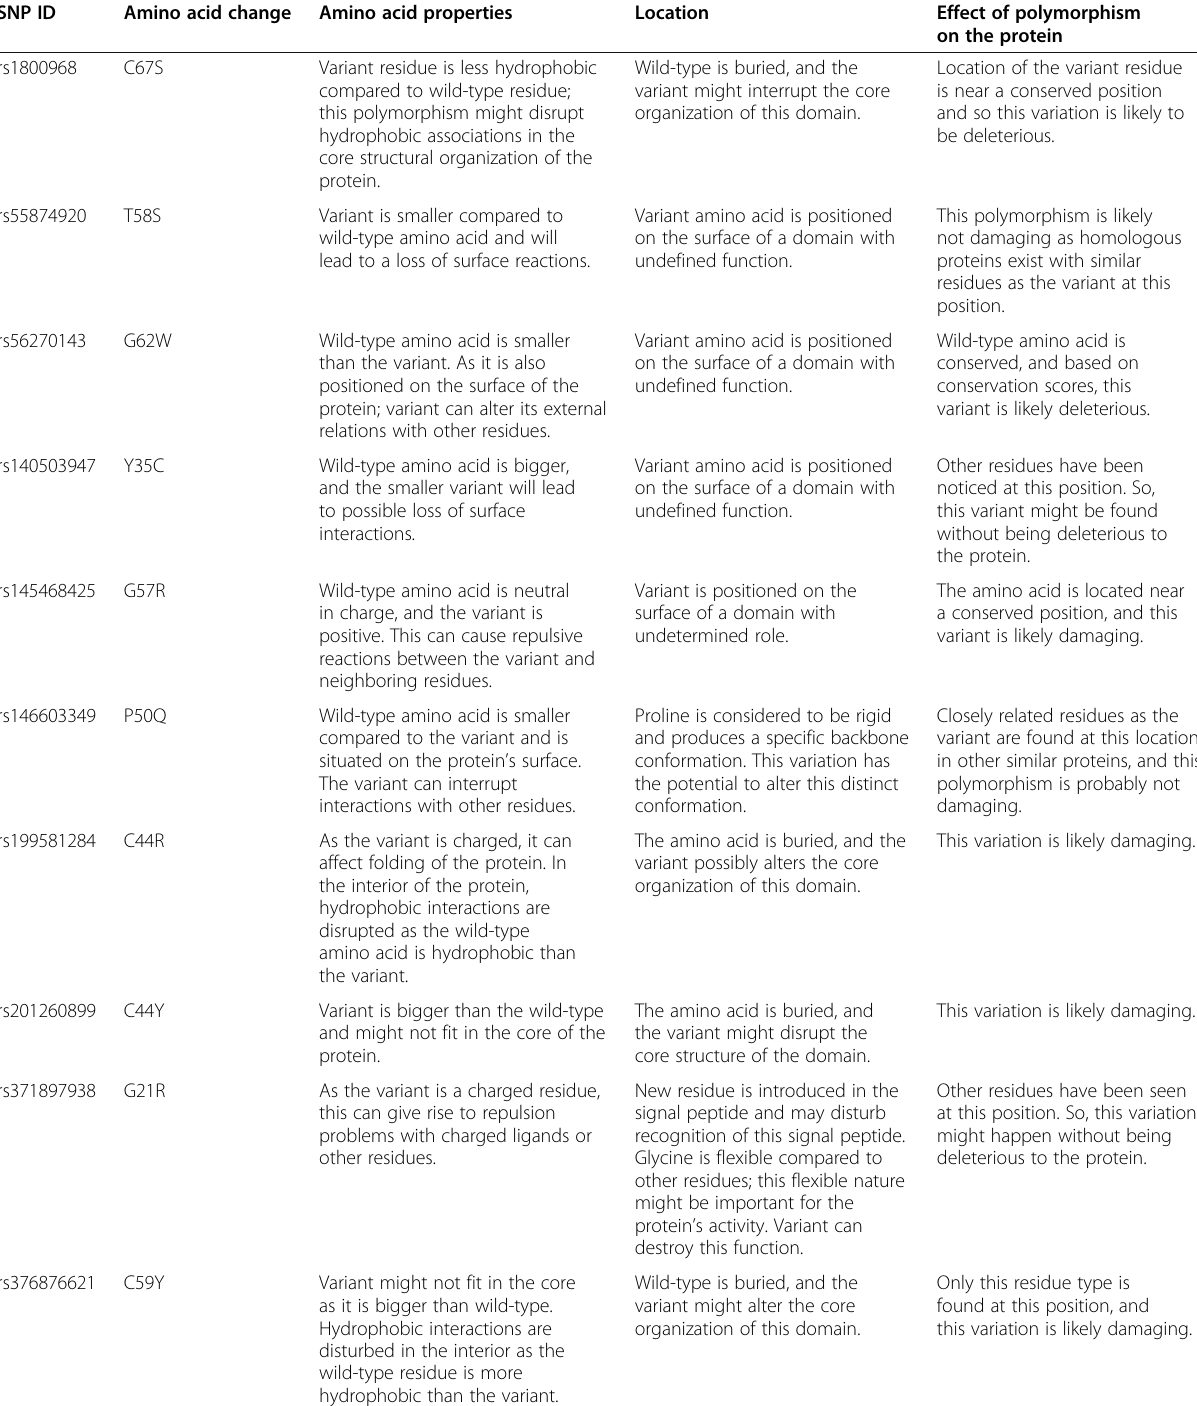
Table 4 Predictions based on the Project HOPE